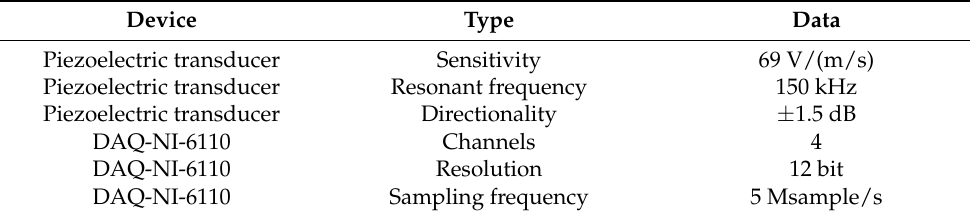
Table 5. Characteristics of instrumentation used for data collection.